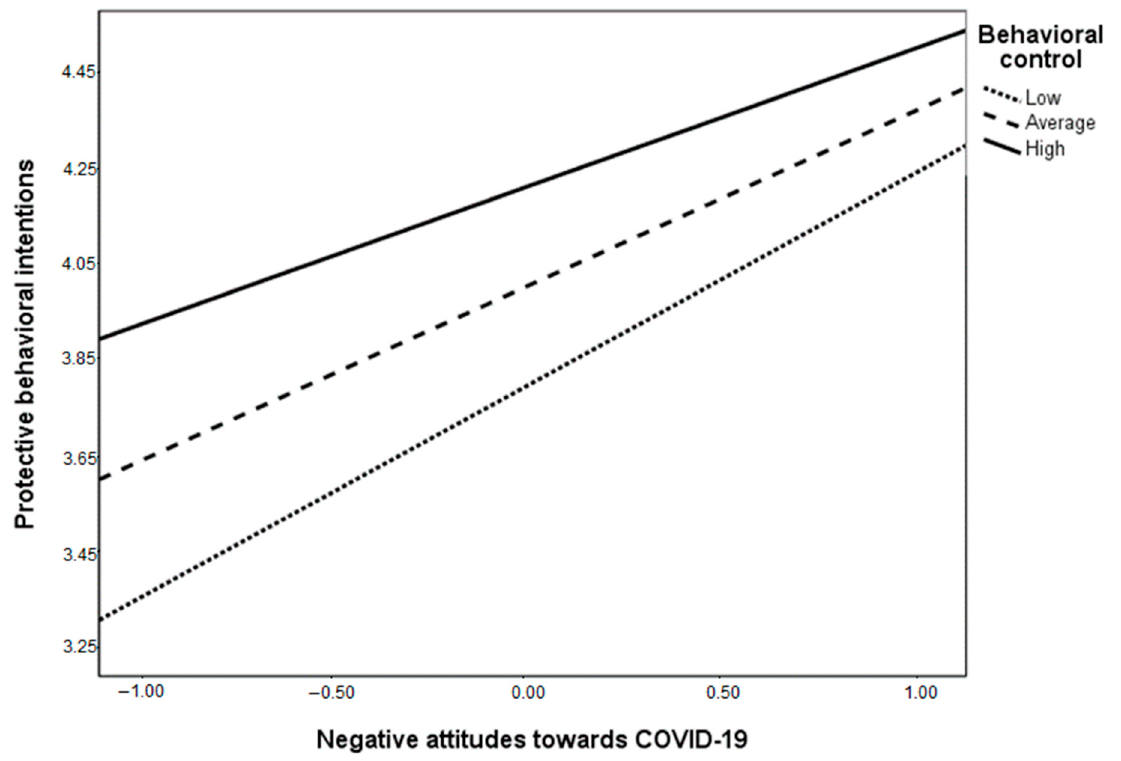
Figure 3. The interaction between negative attitudes towards COVID-19 and behavioral control in protective behavioral intentions. Note: BC = behavioral control; conditional effects of exposure to general information about COVID-19 on negative attitudes are: B = 0.51, SE = 0.05, p < 0.001 for low BC; B = 0.42, SE = 0.04, p < 0.001 for average BC and B = 0.33, SE = 0.05, p < 0.001 for high BC .